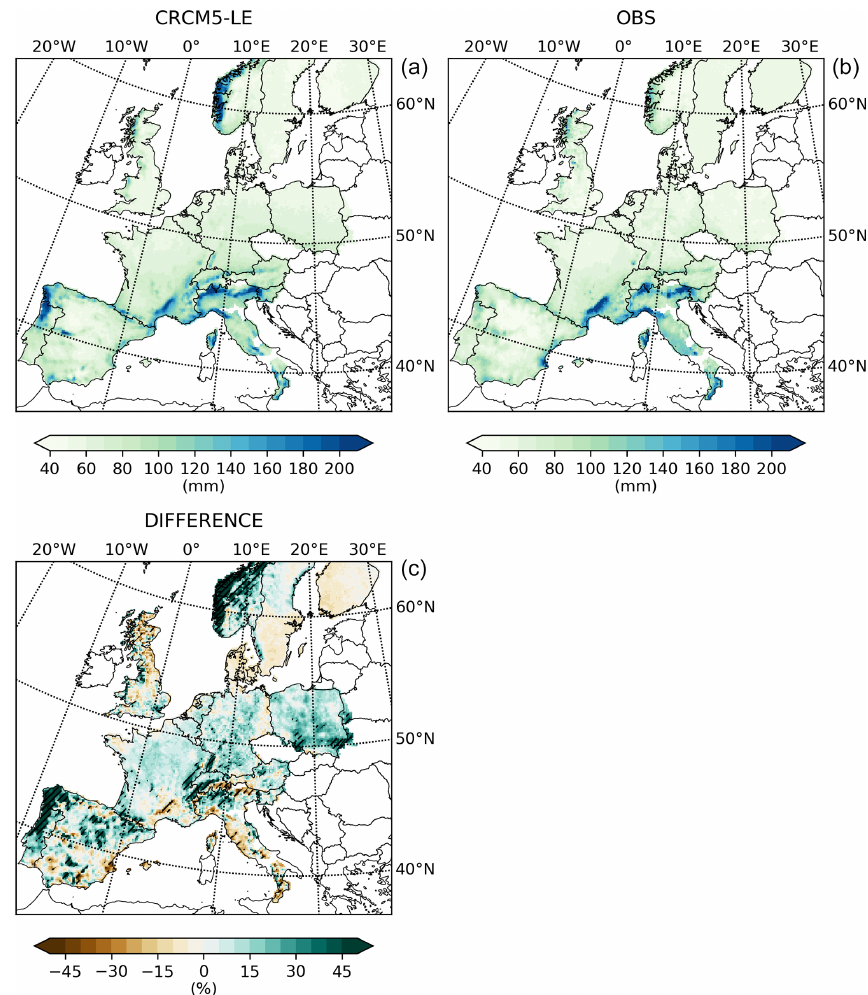
Figure 4. The 10-year return levels of 24h precipitation over parts of Europe. The CRCM5-LE data (a) are compared to an observational data set (b) , and the percentage deviation (c) is shown. Areas where the observations are not in the range of the CRCM5-LE are